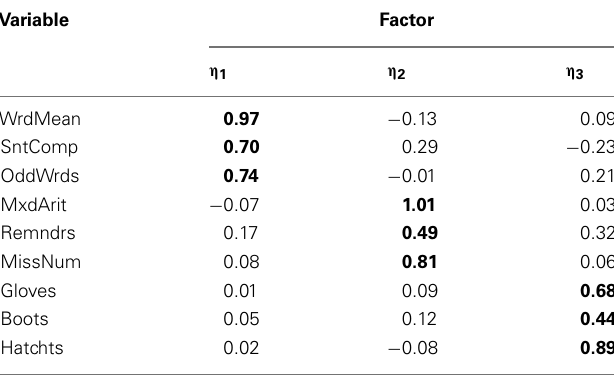
Table 4 | Factor loading matrix obtained with perturbed sample